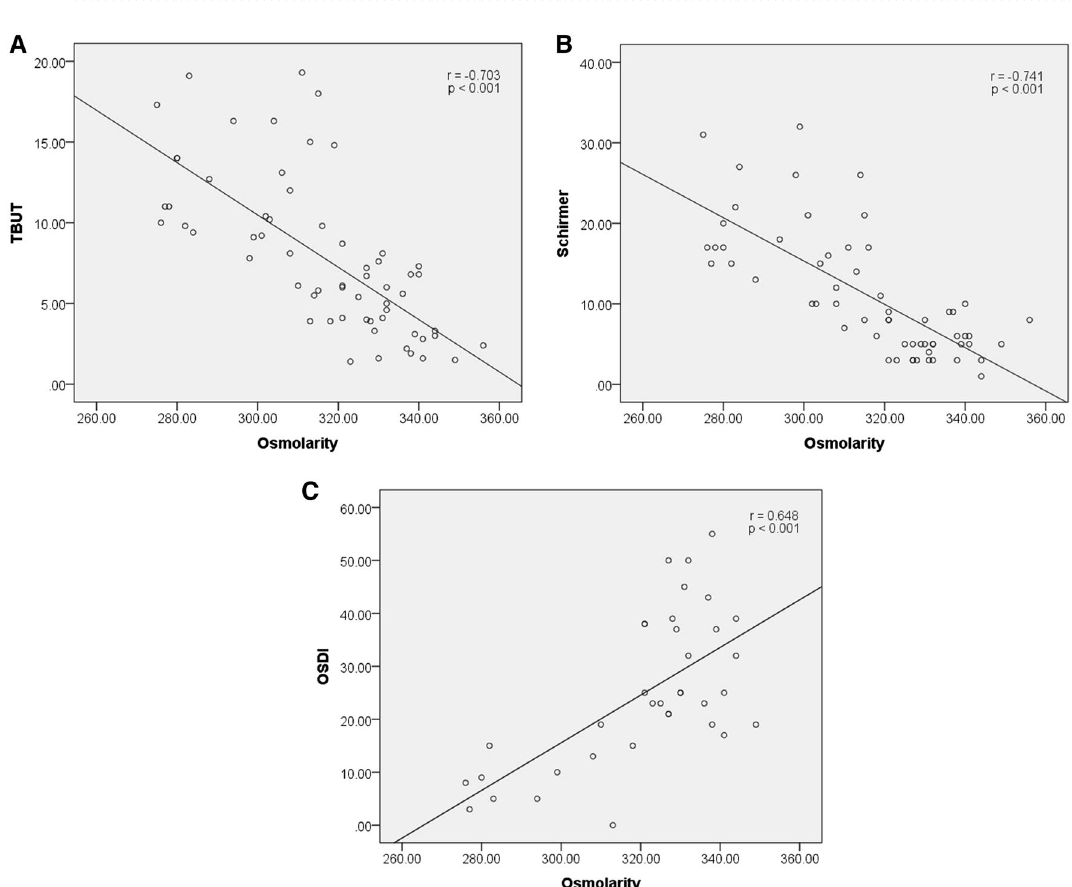
Figure 1. Correlation between tear osmolarity and other dry eye parameters (Tear break-up time (TBUT), Schirmer test, Ocular Surface Disease Index (OSDI) score). ( A ) negative correlation between TBUT and osmolarity; ( B ) negative correlation between Schirmer test and osmolarity; ( C ) positive correlation between OSDI and